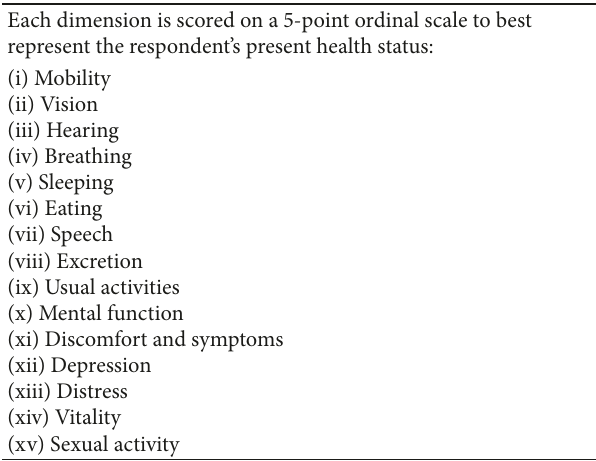
Table 1: 15D health state dimensions. Each dimension is scored on a 5-point ordinal scale to best represent the respondent’s present health